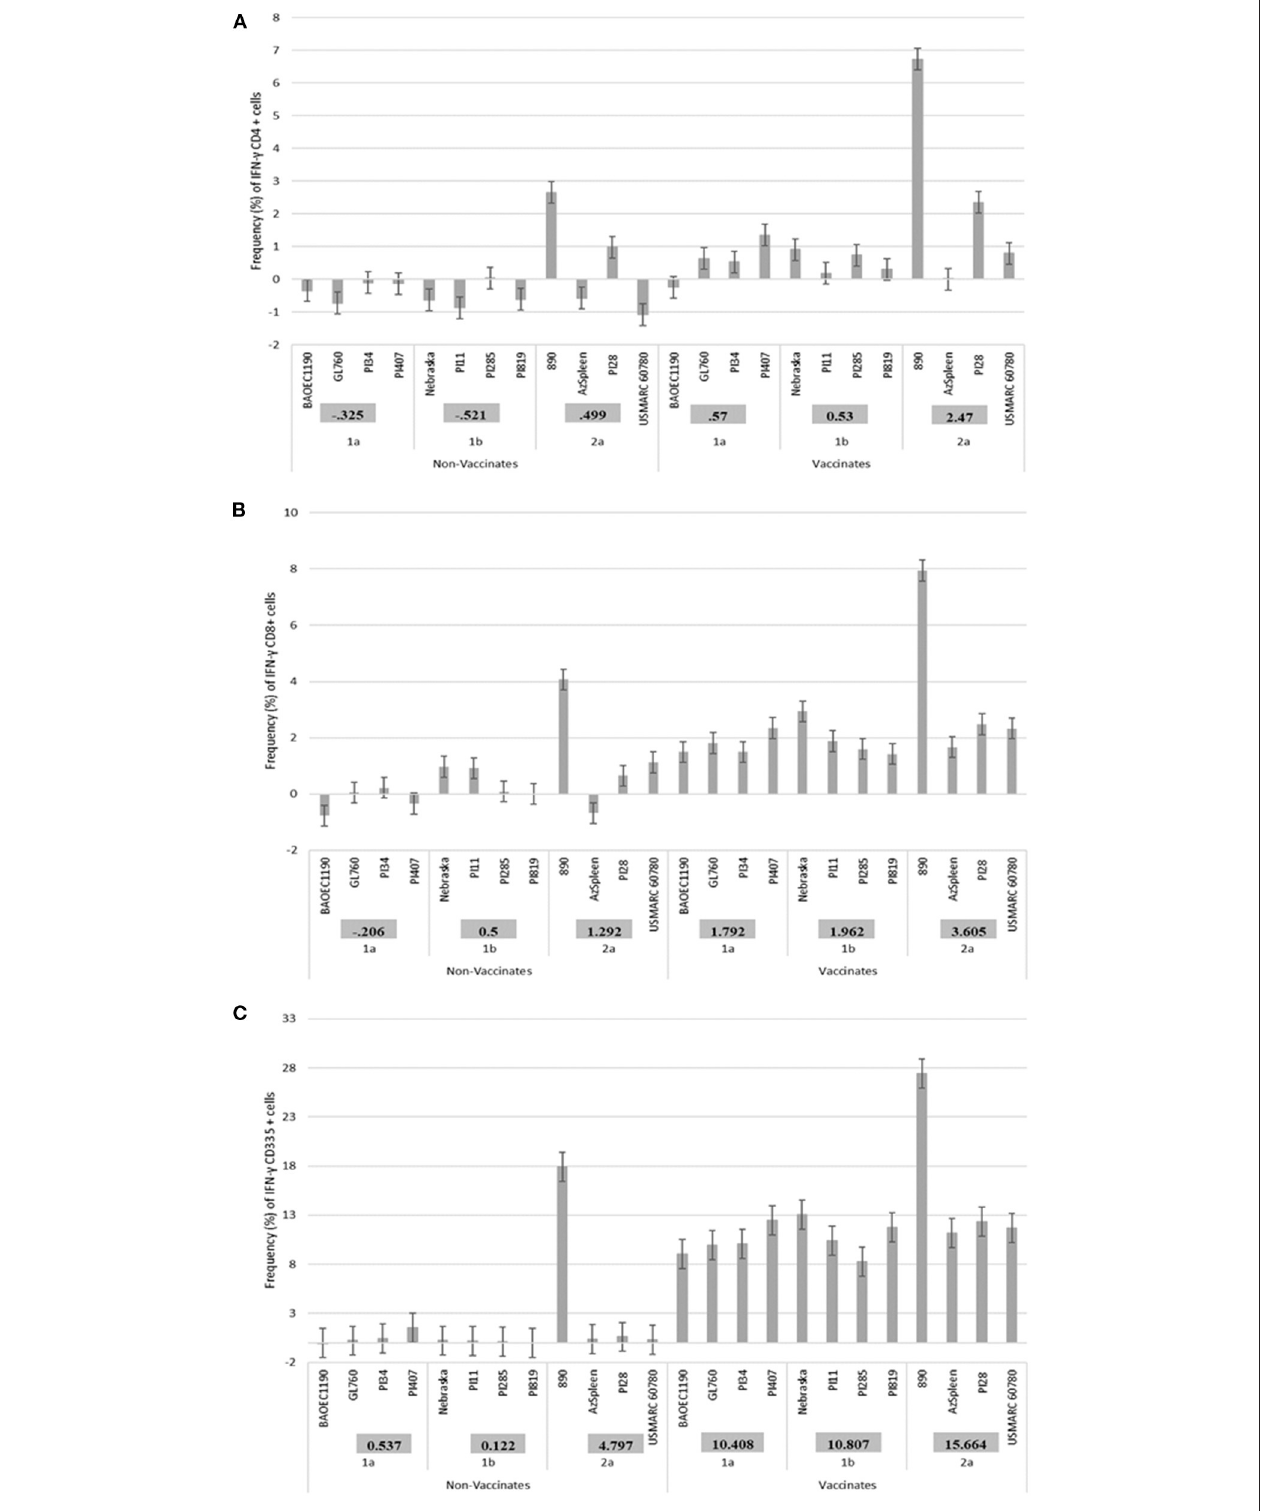
FIGURE 1 | Percent positive cells for each respective PBMC subset (A) CD4 + , (B) CD8 + , (C) CD335 + for IFN- γ mRNA expression in Group 1 vaccinated and non-vaccinated calves at ∼ 10–11 months post-initial vaccination and stimulated with 12 different BVDV strains (4 BVDV-1a, 4 BVDV-1b, and 4 BVDV-2a).